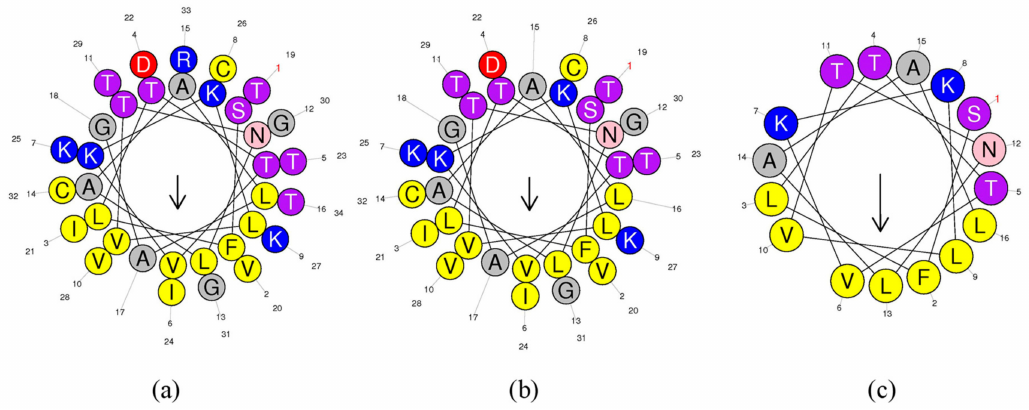
Figure 2. Heliquest of peptides. Heliquest of ( a ) ranatuerin-2Pb, ( b ) RPa and ( c ) RPb. Table1. Physio-chemicalpropertiesofRanatuerin-2Pb, RPaandRPbcalculatedbyHeliQuestonlinetool.